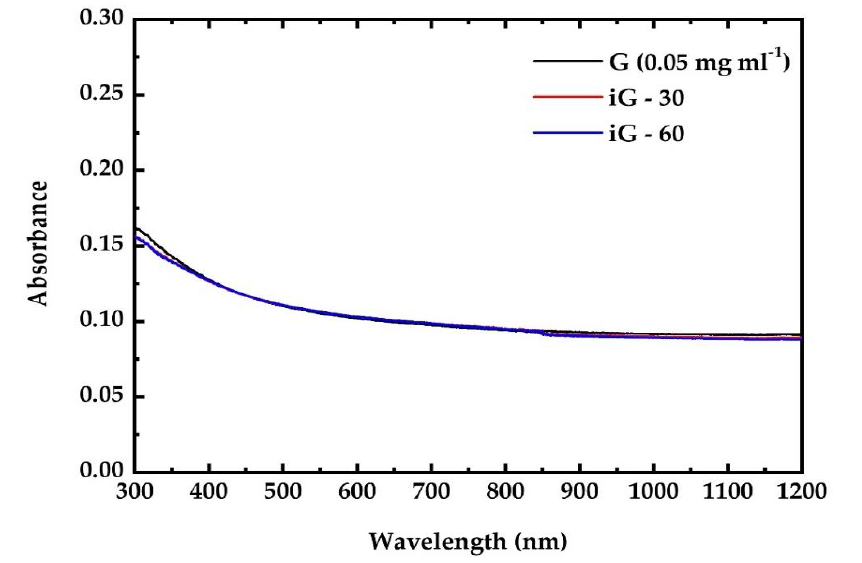
Figure 3. UV – Vis – NIR absorption spectra of pristine and irradiated G dispersion. Figure 3. UV–Vis–NIR absorption spectra of pristine and irradiated G